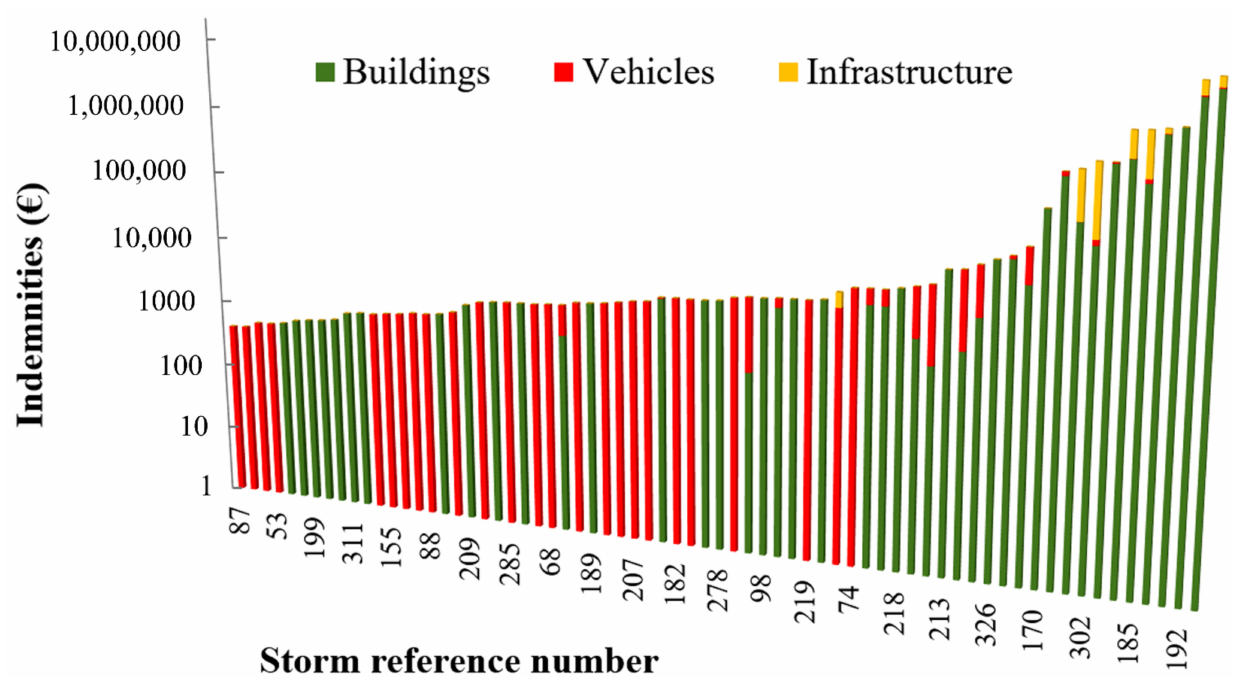
Figure 6. Classification of compensation amounts in the different categories of